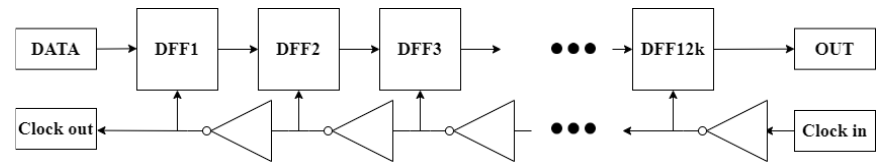
Figure 3. Flip-flop chain and the clock data flow for the shift register design.